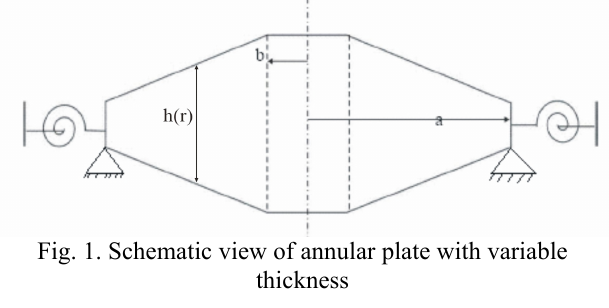
Fig. 1. Schematic view of annular plate with variable